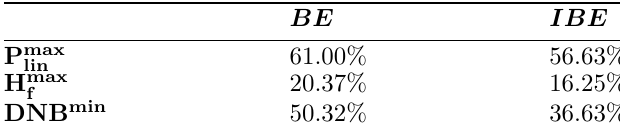
Table B.5. Relative standard deviations estimated by the training LHS of size 250 for BE and